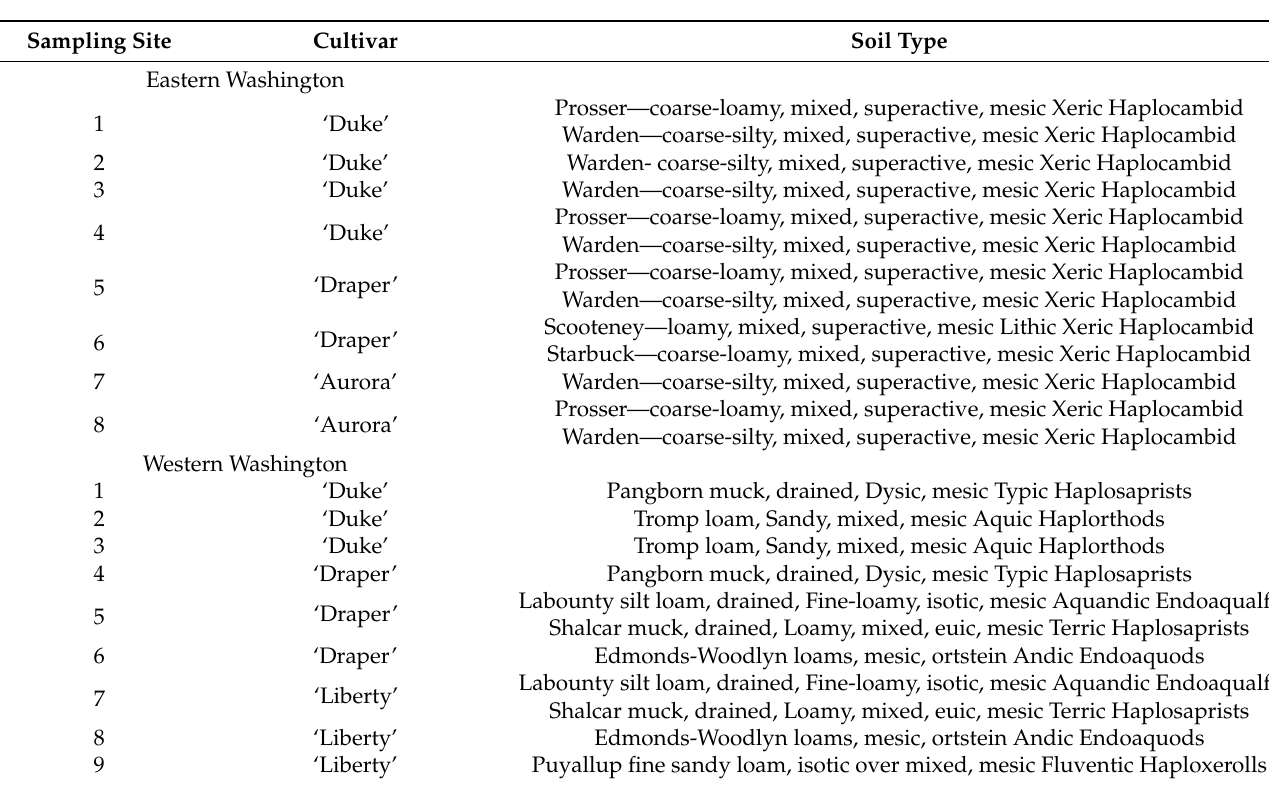
Table 4. Description of cultivars and soil type characteristics for sampled study sites in eastern and western Washington,